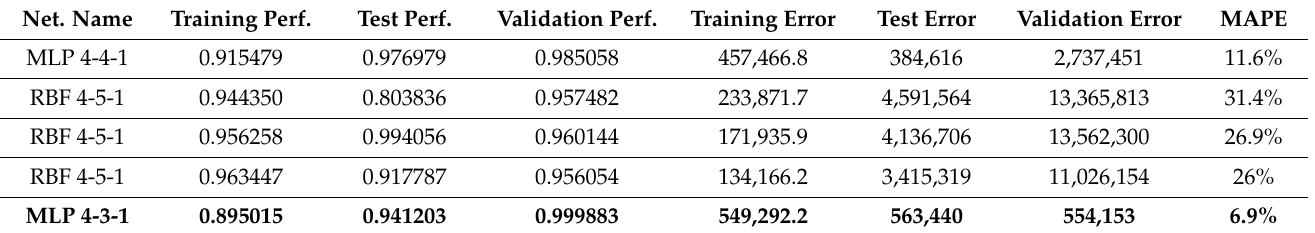
Table 9. Alternative multivariate models for forecasting the gross value added of Y manufacturing . Net. Name Training